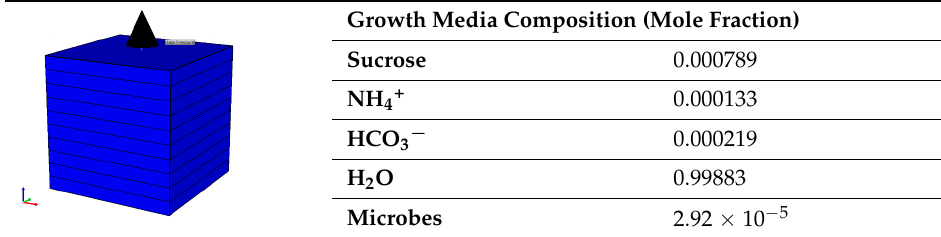
Table A1. Batch model for bacterial growth and dextran generation [54].